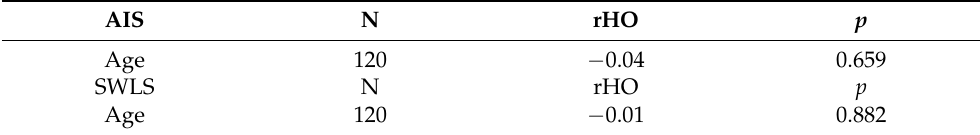
Table 7. Acceptance of illness and satisfaction with life versus